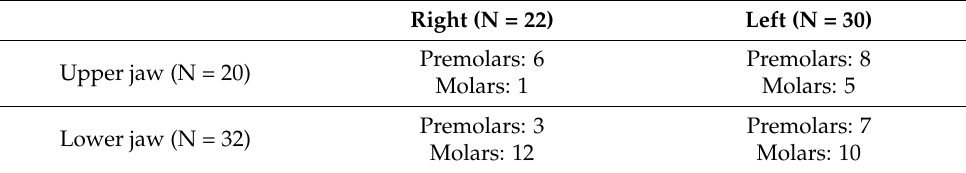
Table 1. Distribution of the implants according to regions and tooth groups (premolars or molars). Right (N = 22) Left (N = 30) Upper jaw (N = 20)